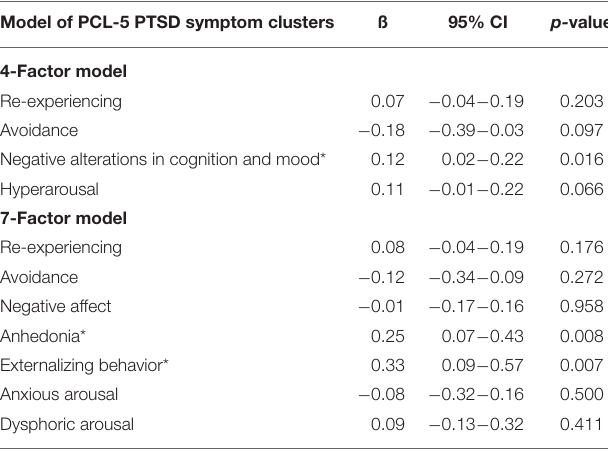
TABLE 3 | Results of linear regression for the associations between PTSD symptom clusters and suicide risk in different models. Model of PCL-5 PTSD symptom